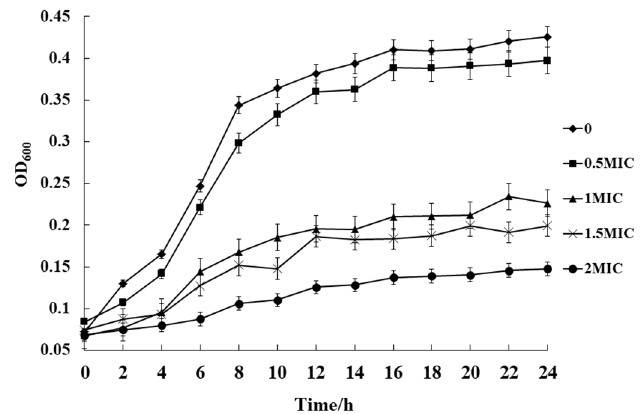
Figure 1. Growth curves of S. aureus ATCC 13565 cultured in Luria-Bertani (LB containing with 0, 0.5, 1, 1.5, and 2 MIC of ATCE. Error bars denote standard deviation ( n = 3).